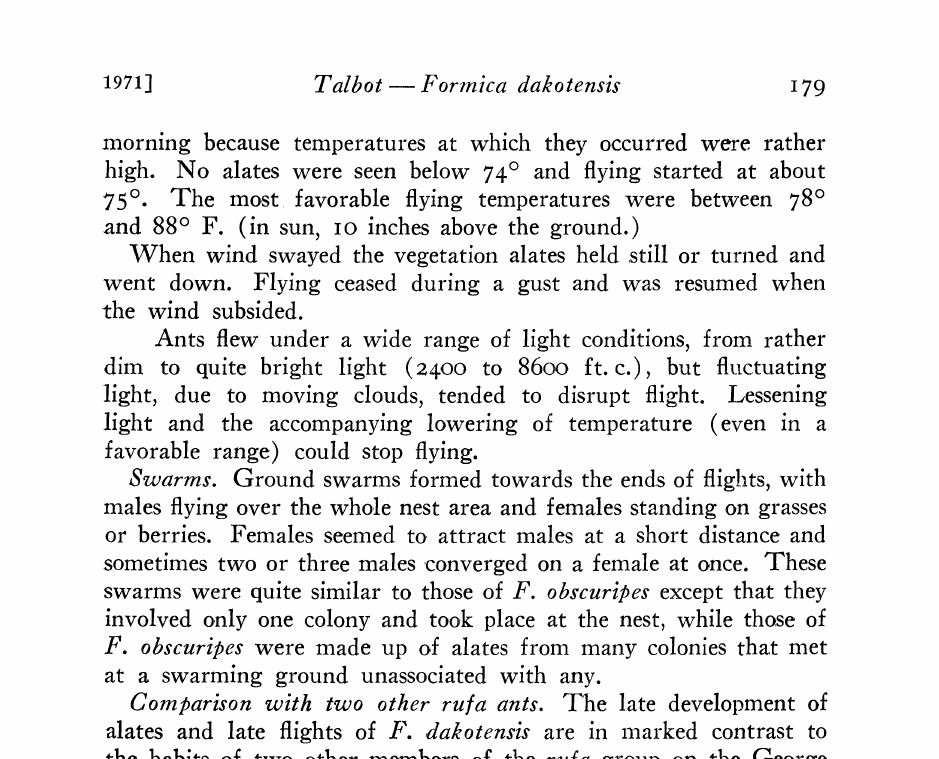
Table II gives a summary o flights o the three